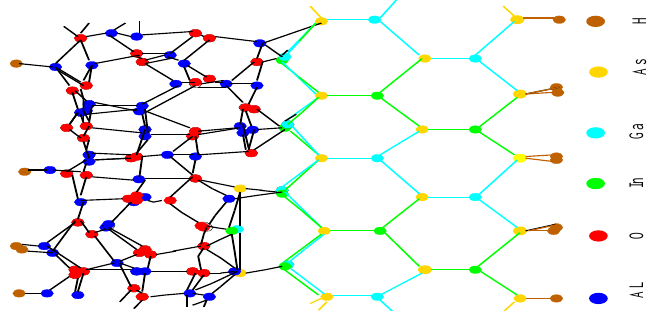
Figure 3. The amorphous oxide interface ( InGaAs − Al 2 O 3 ) shows the initial structure of oxide bulk placed on the clean semiconductor–oxide interface.